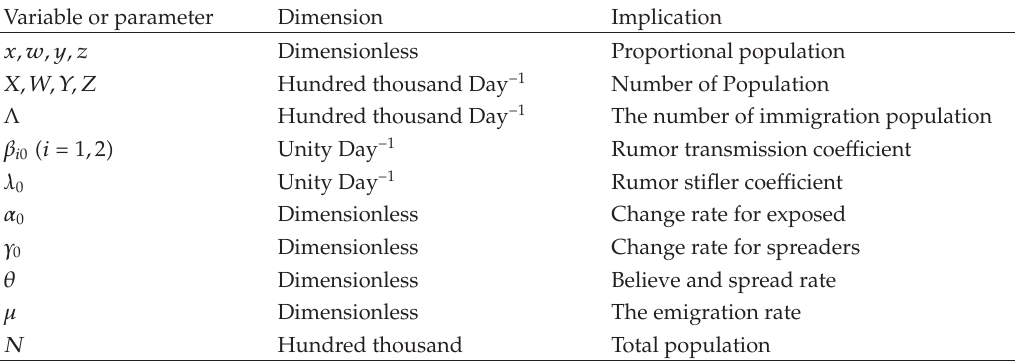
Table 1: Dimension of parameters and variables used in simulations.